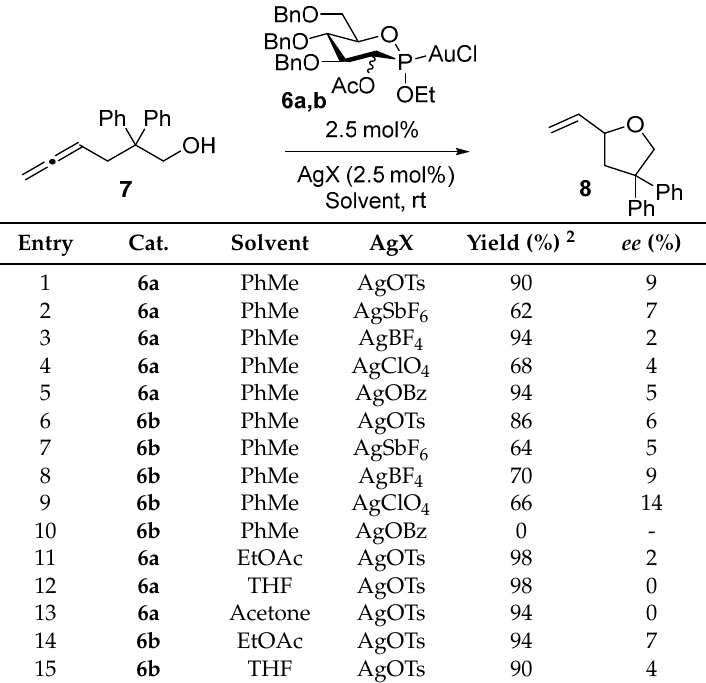
Table 1. Catalytic activity of Au(I) complexes 6a and 6b 1 .